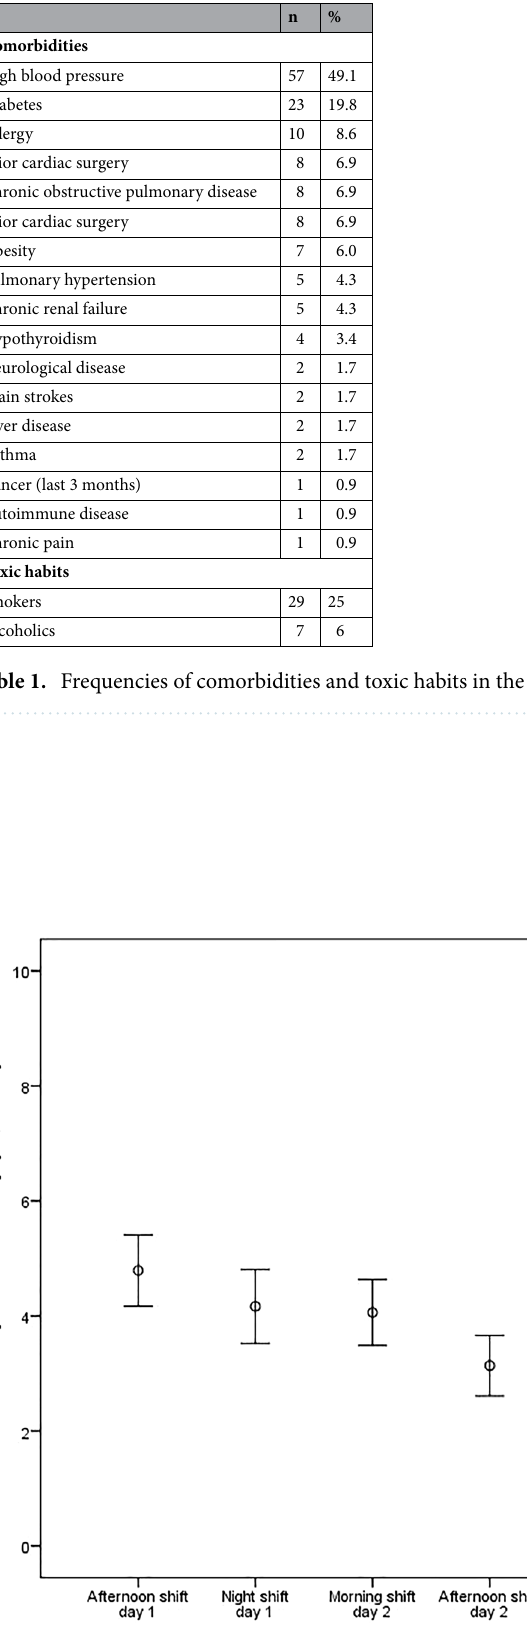
Figure 1. Decrease in mean pain intensity (CI, 95%) over the course of successive shifts in the first 48 h of the postoperative period, according to the verbal numerical rating scale (p <